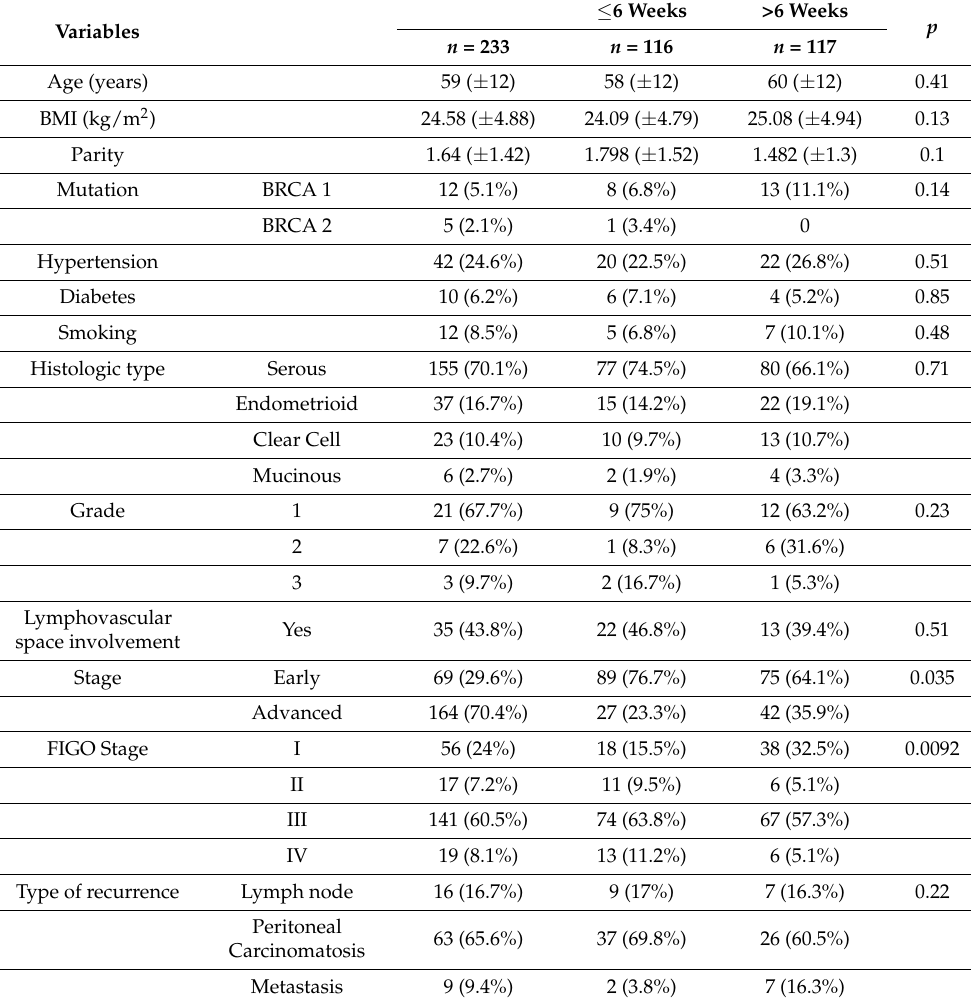
FIGO: International Federation of Gynecology and